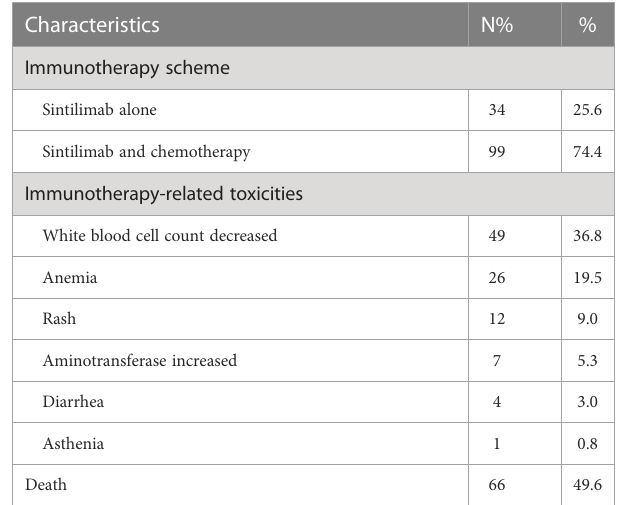
TABLE 1 Patient characteristics at baseline (N =